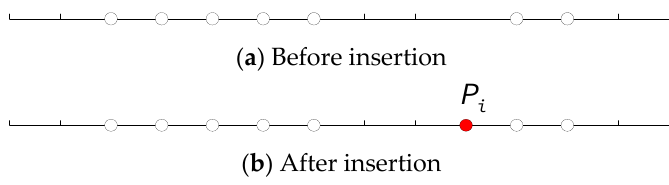
Figure 7. Control point insertion in the topology of an I-spline curve.